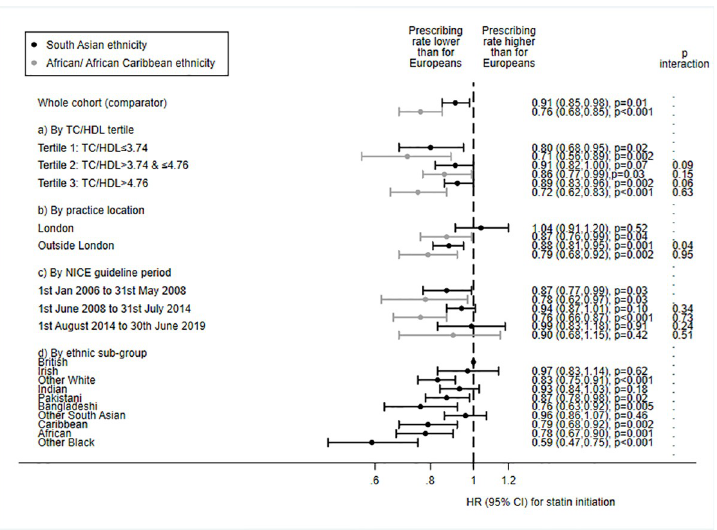
Fig 2. Associations between ethnicity and guideline-indicated statin initiation after type 2 diabetes diagnosis: Sub-group analyses. Sub-group analyses by (a) total cholesterol/high-density lipoprotein cholesterol ratio (TC/HDL) tertile, (b) London practice location AU : InthelegendforFig 2 ; IchangedLondonresidencetoLondonpracticelocation : Ifthisisnotcorrect ; pleaseedit : , (c) time period of National Institute for Health and Care Excellence (NICE) guidelines, and (d) ethnic sub-group. Data are HRs (marker) and 95% CIs (capped lines) adjusted for age, gender, deprivation, smoking, healthcare usage, TC/HDL, BMI, prevalent comorbidity, medication usage, and antihypertensive usage, from multilevel models accounting for intra-practice clustering. European ethnicity = referent category, i.e., HR for people of European ethnicity =